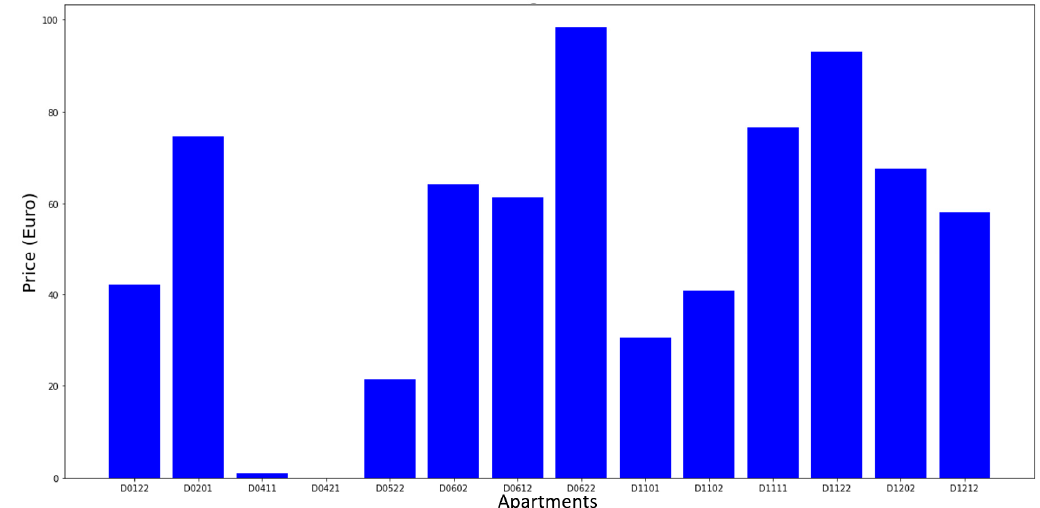
Figure 27. Annual savings in the hot water consumption.